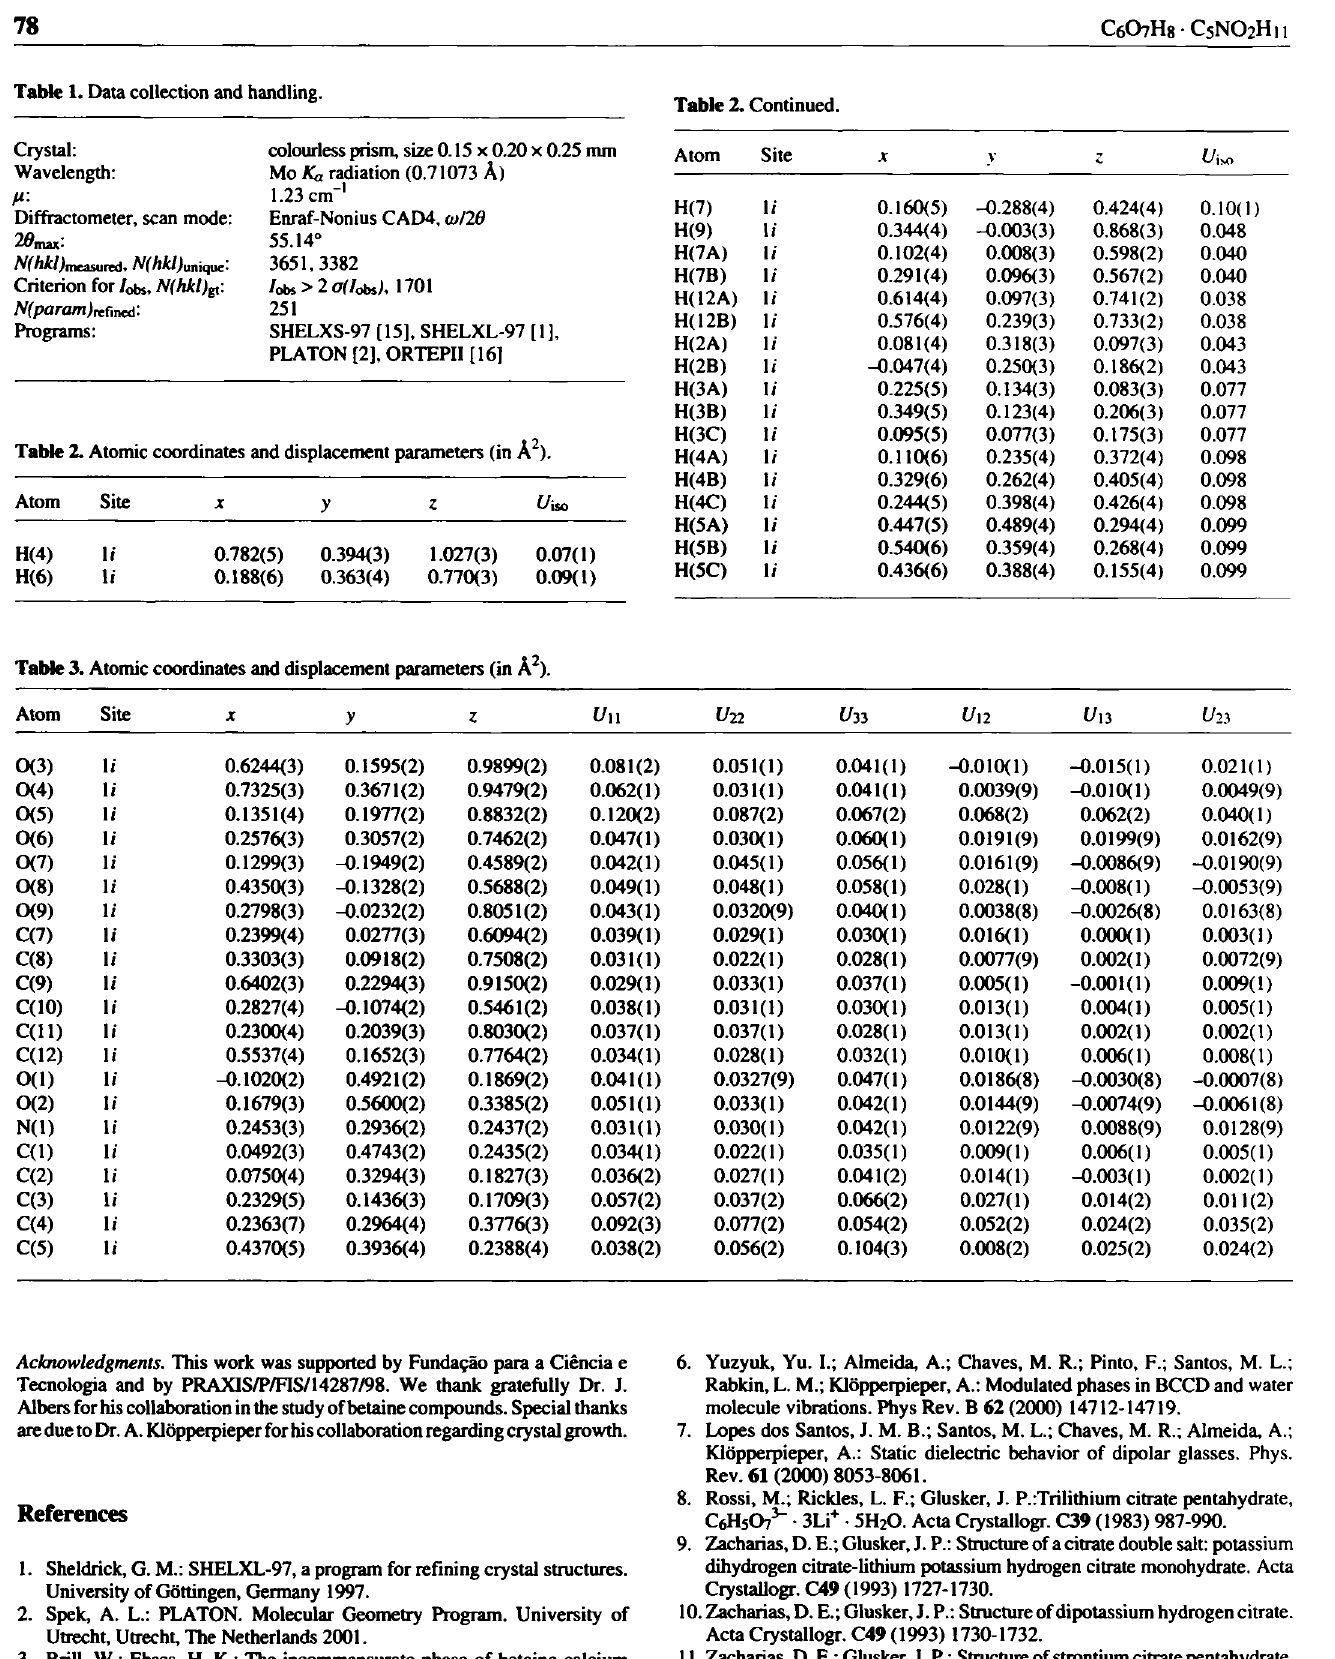
Table 3. Atomic coordinates and displacement parameters (in À 2